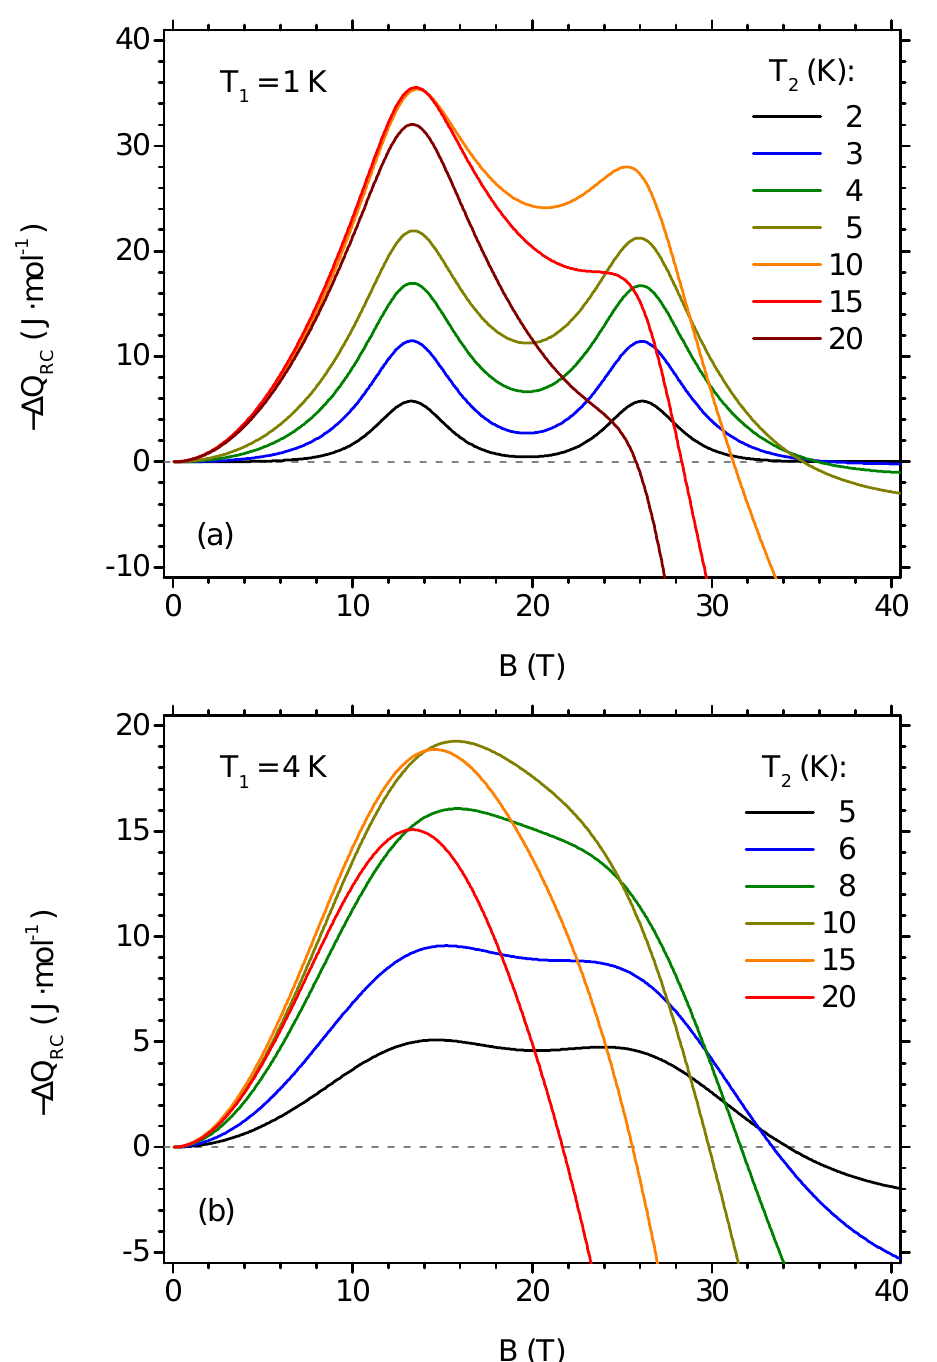
Figure 9. The dependence of the refrigerant capacity per mole on the initial value of the external magnetic field in the isothermal process (the final value of the magnetic field is zero), for selected fixed temperature ranges, with initial temperature T 1 of 1 K ( a ) and 4 K ( b ), for selected final temperatures T 2